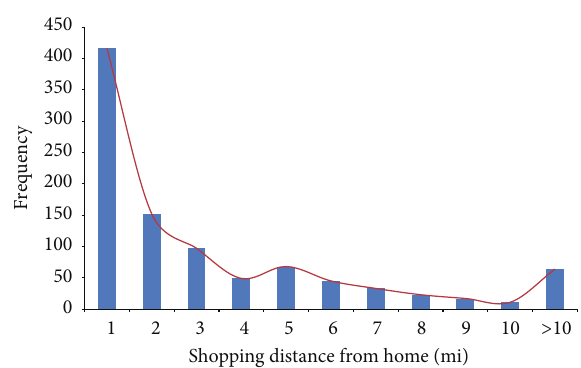
Figure 6: Distribution of travel time for the home-based travel-to- shop